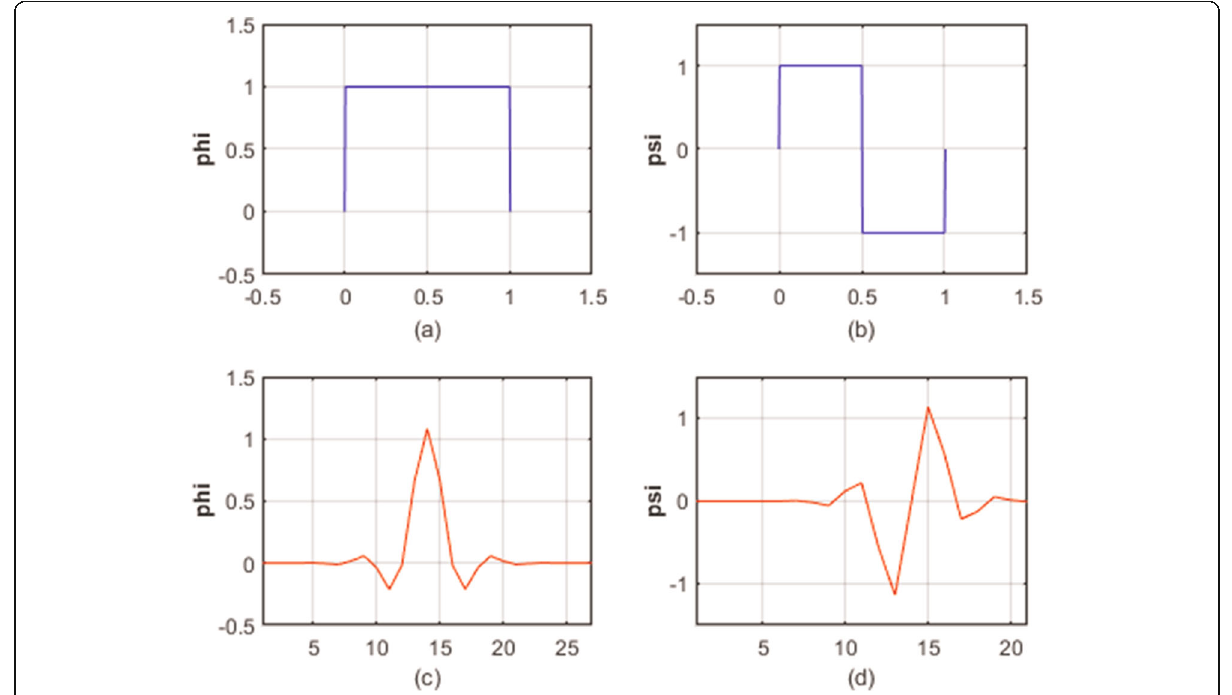
Fig. 4 a Haar scaling function. b Haar mother wavelet. c Designed scaling function. d Designed mother